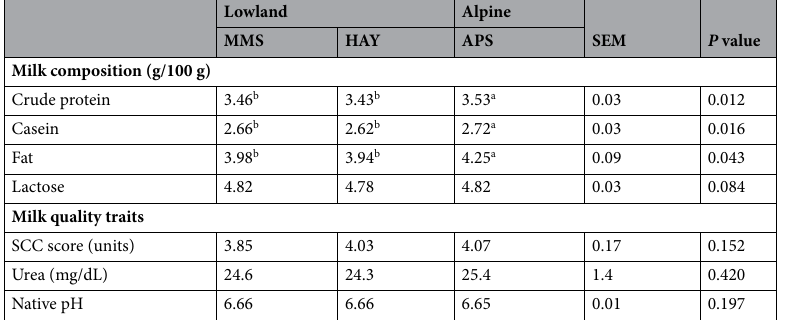
Table 2. Effect of the dietary feeding groups on milk proximate composition and quality traits. SCC, somatic cell count as log 2 (SCC/100,000) + 3; MMS , mix maize/crop silages; HAY , permanent meadow and lucerne hays; APS , Alpine pasture; SEM , standard error of the mean. a,b Least squares means (LSMeans) in a row without a common superscript differ ( p <